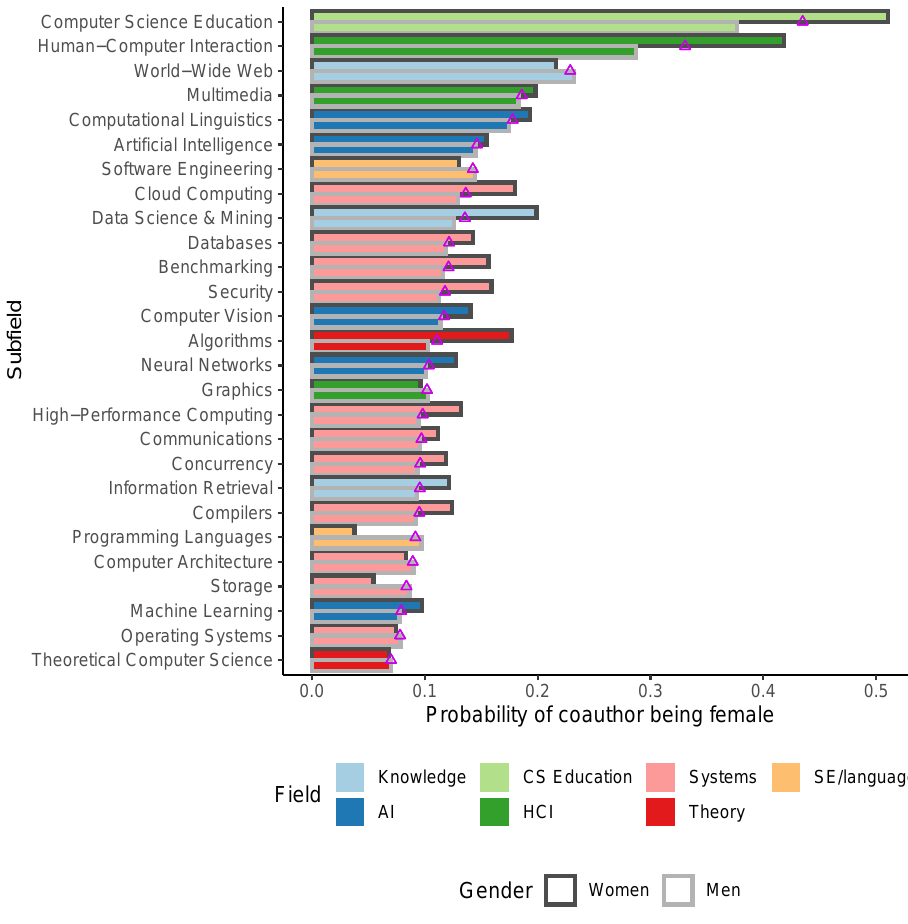
Figure 6. Probability of an author to coauthor with a woman (triangles denote overall probability for subfield, which is similar to FAR but excludes single authors). Women (top bars) show gender homophily when their probability to coauthor with a woman is higher than the overall probability, and men exhibit homophily when their probability is lower than the